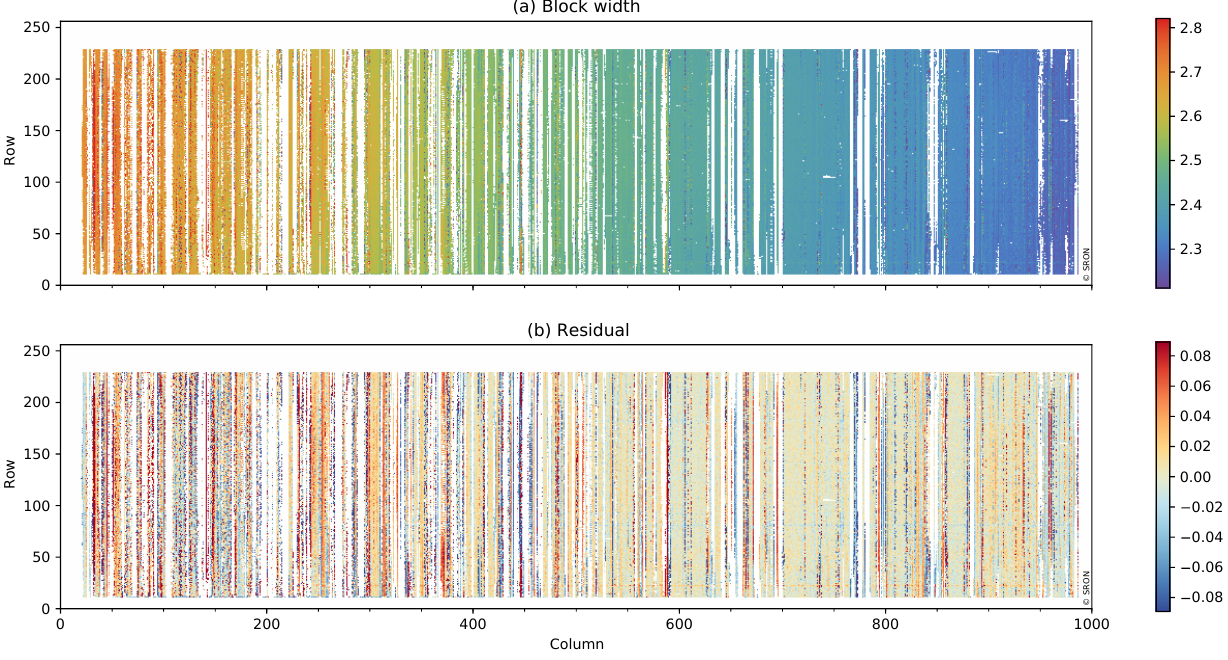
Figure 10. ISRF parameter block width w (irradiance port). Panel (b) shows the difference between w and its bivariate polynomial fit. No measurements are performed in the white edges. White vertical stripes are due to saturation in the measurements. Red vertical stripes are due to nearby saturation or laser